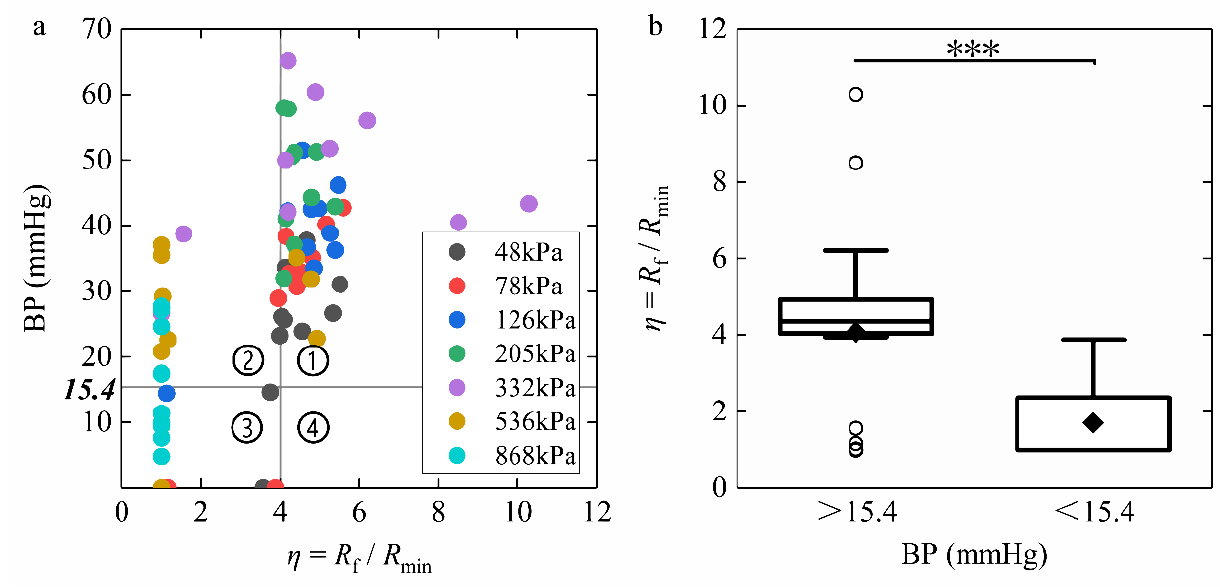
Figure 12. ( a ) Bursting pressure (BP) results affected by the ratio of final impedance to minimum impedance η with four quadrants. Quadrant ① shows that when η exceeds four, BP meets the success criteria despite differences in initial compression pressure. Although η is less than four, BP is successful in Quadrant ② over 332 kPa. The strength of the connection formed by prolonged heating is not stable, so there are also examples of unsuccessful cases in Quadrant ③ . There is no data point in Quadrant ④ , which indicates that BP failure would not occur when η is more than four. ( b ) BP results under η < 4 and η > 4. There is a significant difference in η with BP = 15.4 mmHg as the cut-off point (***: p < 0.001; ○ : outliers; ⬥ : means).